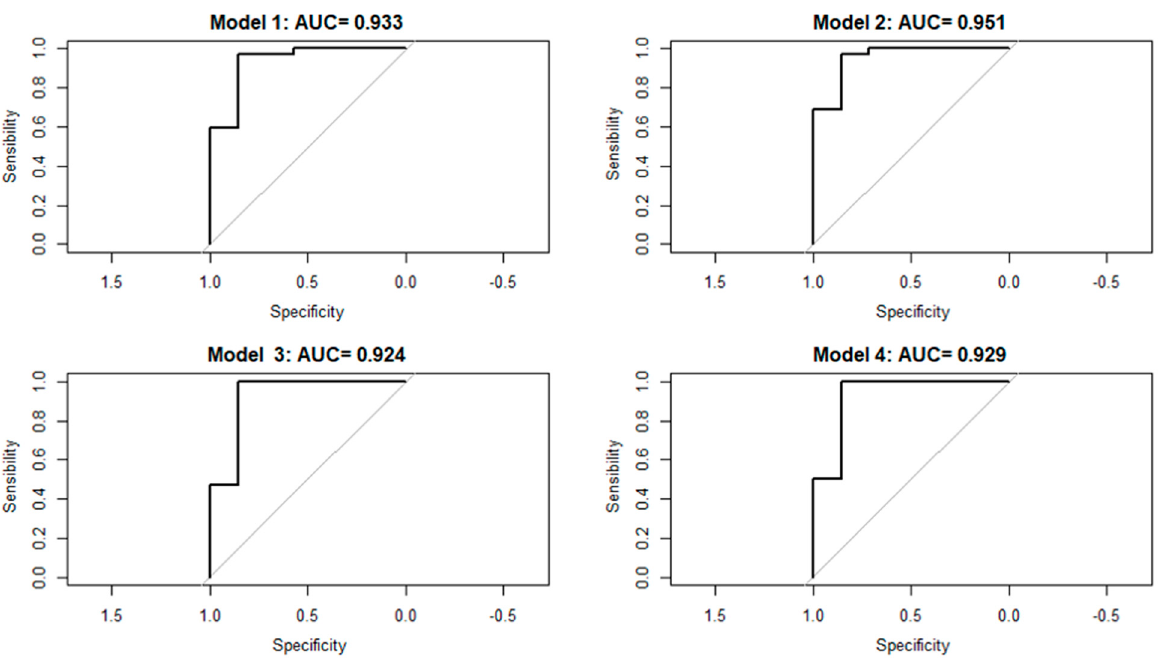
Figure 1. ROC curves for the four selected models. Table 5. Model behavior (precision, sensitivity and specificity) for different groups using different